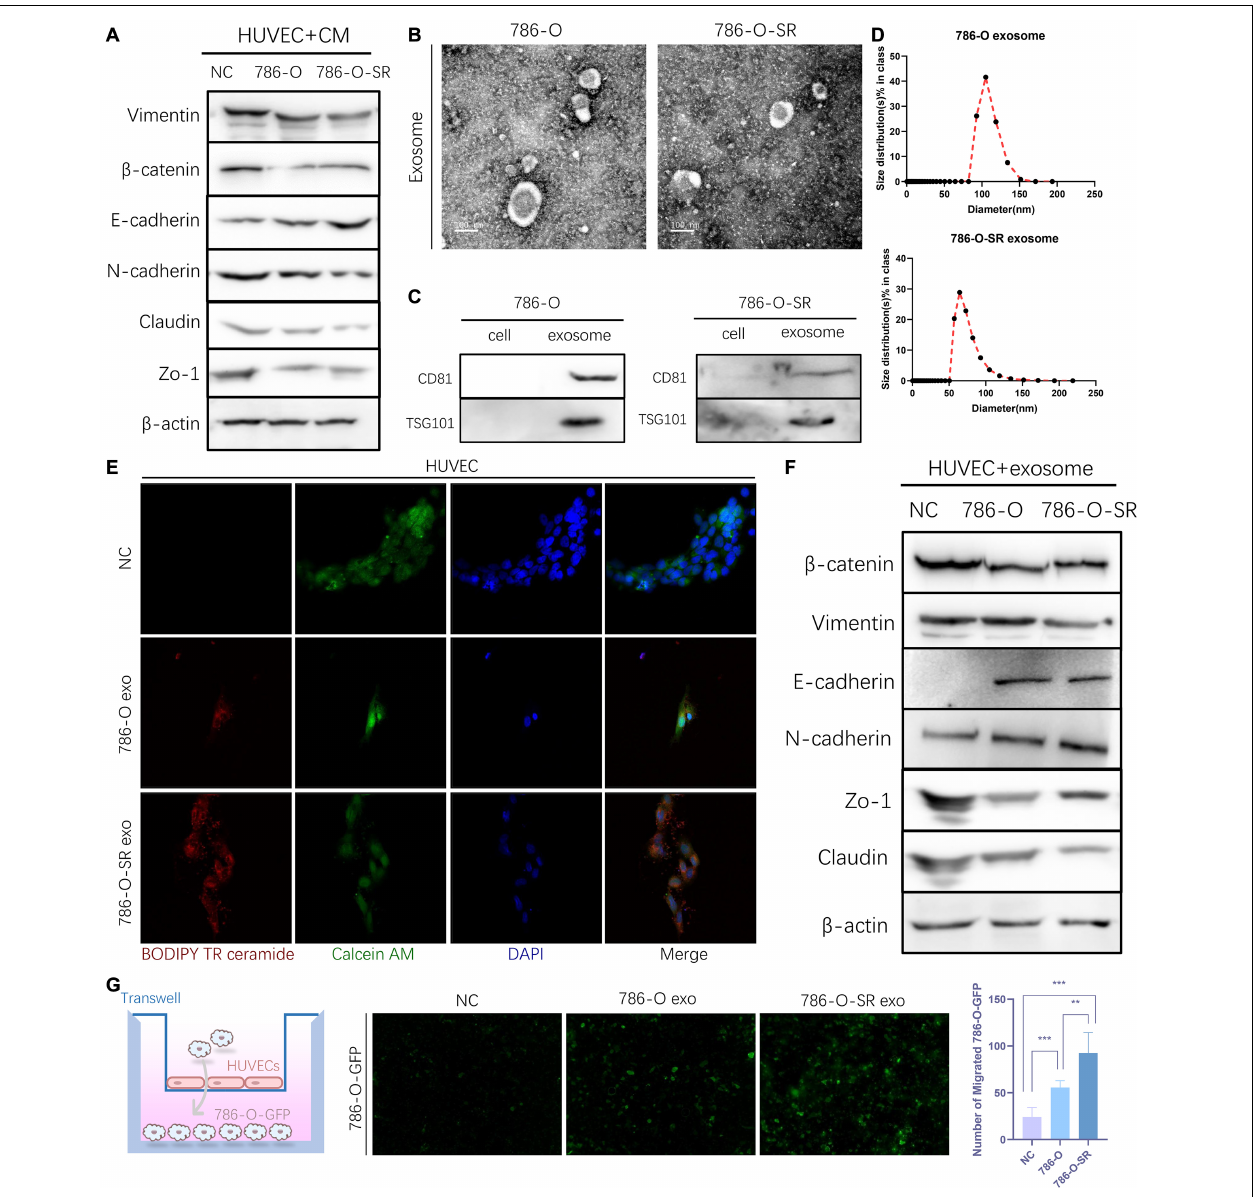
FIGURE 2 | Exosomes derived from Clear cell renal cell carcinoma cells increase the permeability of the endothelial cells. (A) Western blot analysis of Vimentin, β -catenin, E -cadherin, N -cadherin, Zo-1, Claudin expression in HUVECs incubated with CM of 786-O and 786-O-SR. (B) Transmission electron microscopy of exosomes derived from 786-O and 786-O-SR. Scale bar, 100 nm. (C) Western blotting analysis of CD81 and TSG101 in 786-O, 786-O-SR and their exosomes. (D) Nanoparticle tracking analysis of the size distribution and median diameter of particles per µ g exosomes from 786-O and 786-O-SR. (E) The presence of BODIPY TR ceramide fluorescence in HUVECs after adding dye-labeled exosomes derived from 786-O and 786-O-SR cells for 48 h. HUVECs incubated with PBS were used as a negative control. Red: BODIPY TR ceramide; Green: Calcein AM; Blue: DAPI. (F) Western blot analysis of β -catenin, Vimentin, E -cadherin, N -cadherin, Zo-1, Claudin expression in HUVECs incubated with exosomes of 786-O and 786-O-SR. (G) Transendothelial invasion assay analysis of the number of GFP-expressing 786-O cells that invaded through HUVECs monolayers cultured with exosome derived from 786-O or 786-O-SR. Mean ± SEM are provided ( n = 3). ** P < 0.01, *** P < 0.001, according to two-tailed Student’s t -test. exo, exosomes; NC, negative